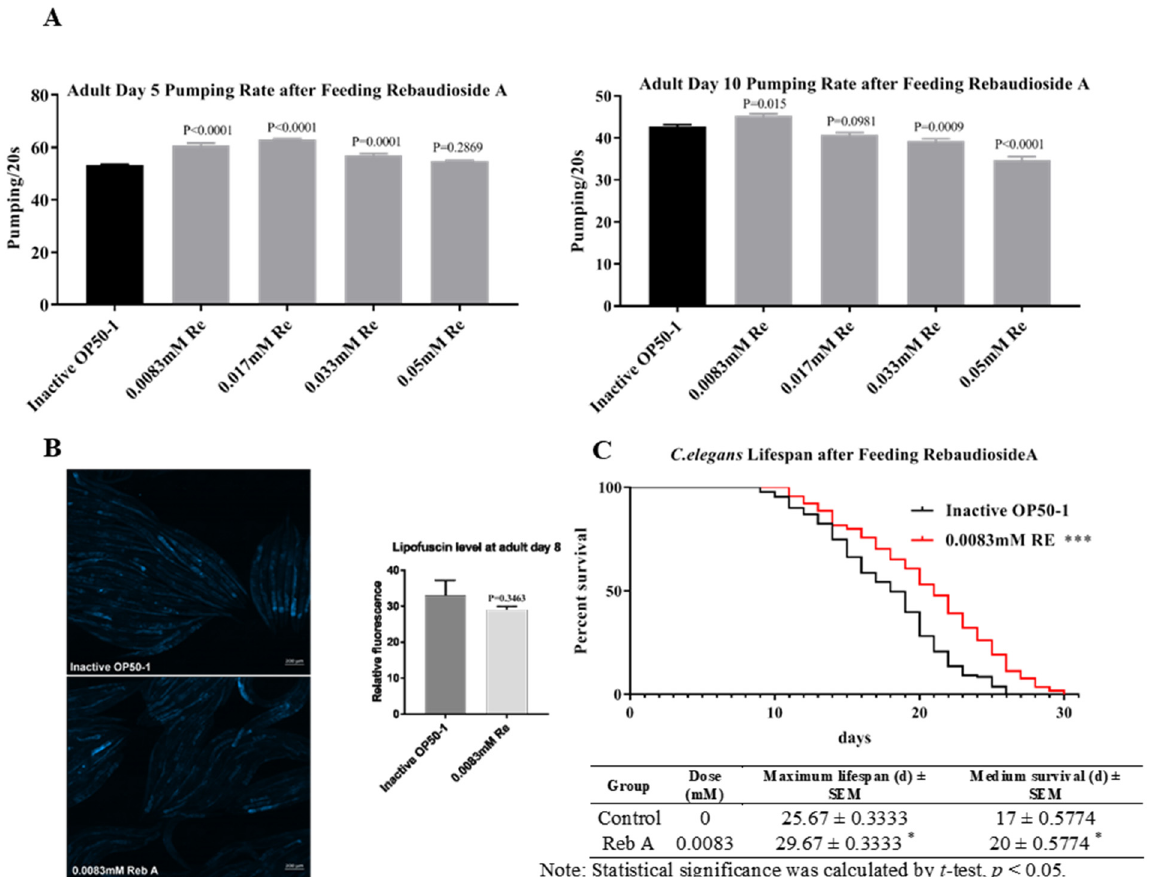
Figure 1. Reb A extends lifespan in C. elegans . ( A ) Pumping rate in worms on the 5th and 10th day of adulthood in wild-type N2 strain on both control nematodes growth media (NGM) and NGM supplemented with rebaudioside A (Reb A) at designated concentrations (0.0083, 0.017, 0.033, and 0.05 mM). One-way ANOVA was used for multiple group comparisons and pairwise significance was evaluated by Dunnet’s test; ( B ) Lipofuscin fluorescence in worms on the 8th day of adulthood grown under control NGM and 0.0083 mM Reb A NGM. Statistical significance was calculated by unpaired t -test; ( C ) Survival plot and lifespan assay comparing worms grown on control NGM and that supplemented with 0.0083 mM Reb A. Statistical significance was calculated by log-rank (Mantel–Cox) test, * p < 0.05, *** p < 0.001. Maximum and medium survival were shown in the table appended below.